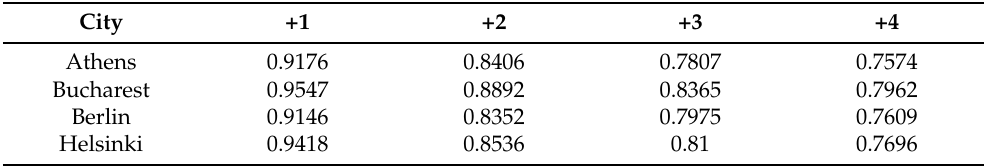
Table 5. Correlation coefficients of predicted CMF by hyb_r with the actual time series for four cities for four lead time steps (+1 to +4) in